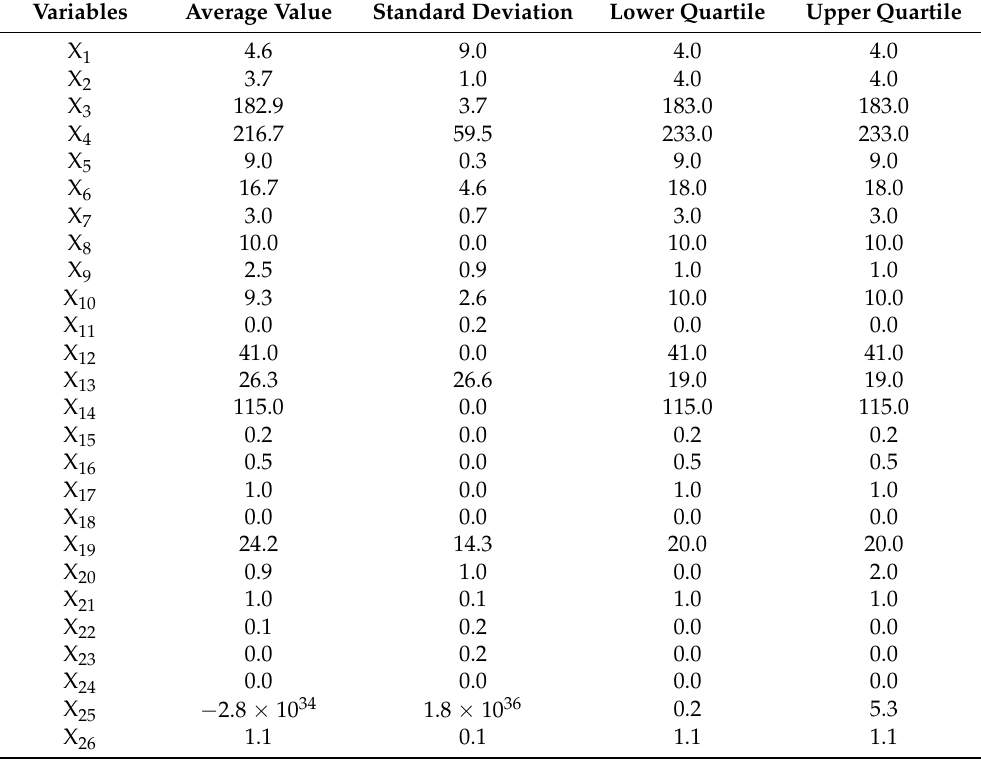
Table 4. Statistical information of the data